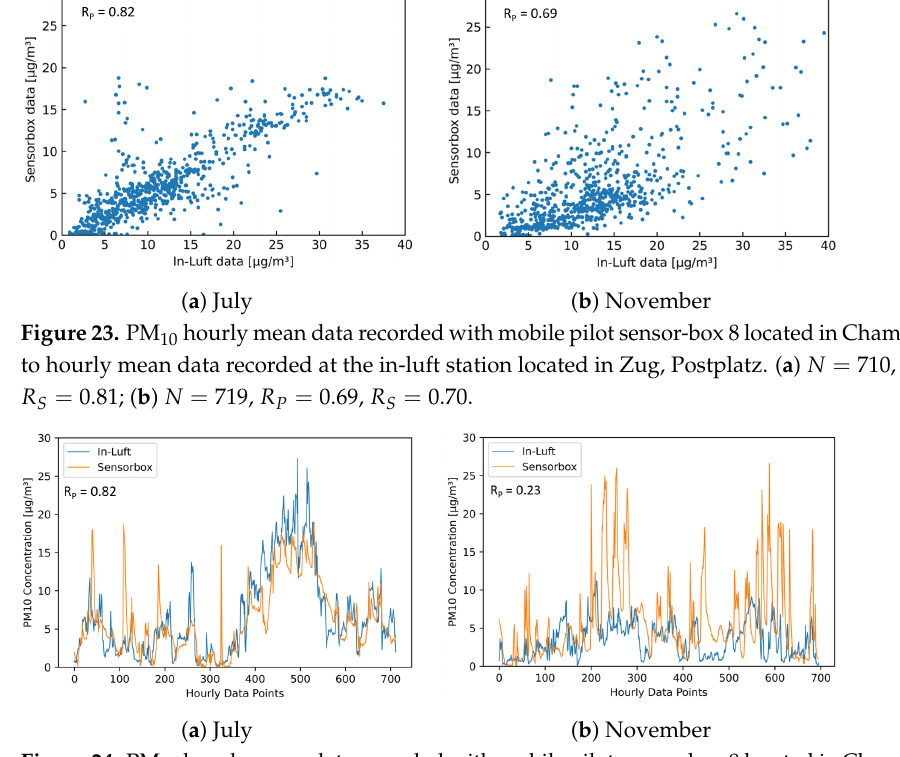
Figure 24. PM 10 hourly mean data recorded with mobile pilot sensor-box 8 located in Cham compared to hourly mean data recorded at the in-luft station located in Rigi, Seebodenalp. Data gaps are removed from the graph. ( a ) N = 712, R P = 0.82, R S = 0.81; ( b ) N = 696, R P = 0.23, R S =